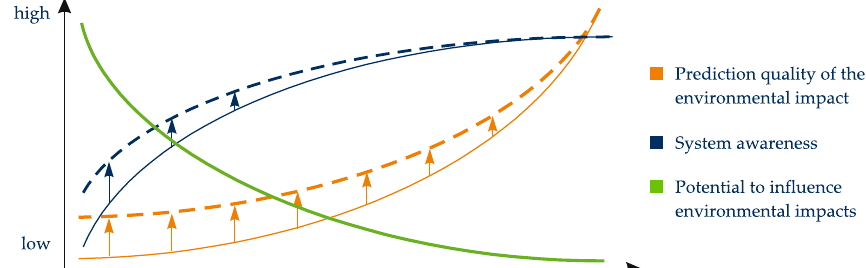
Fig. 5 The Collingridge dilemma: system